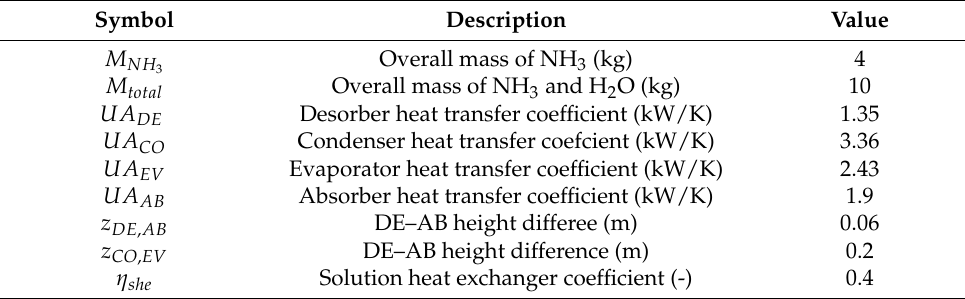
Table 4. Example of parameters of state vector values.